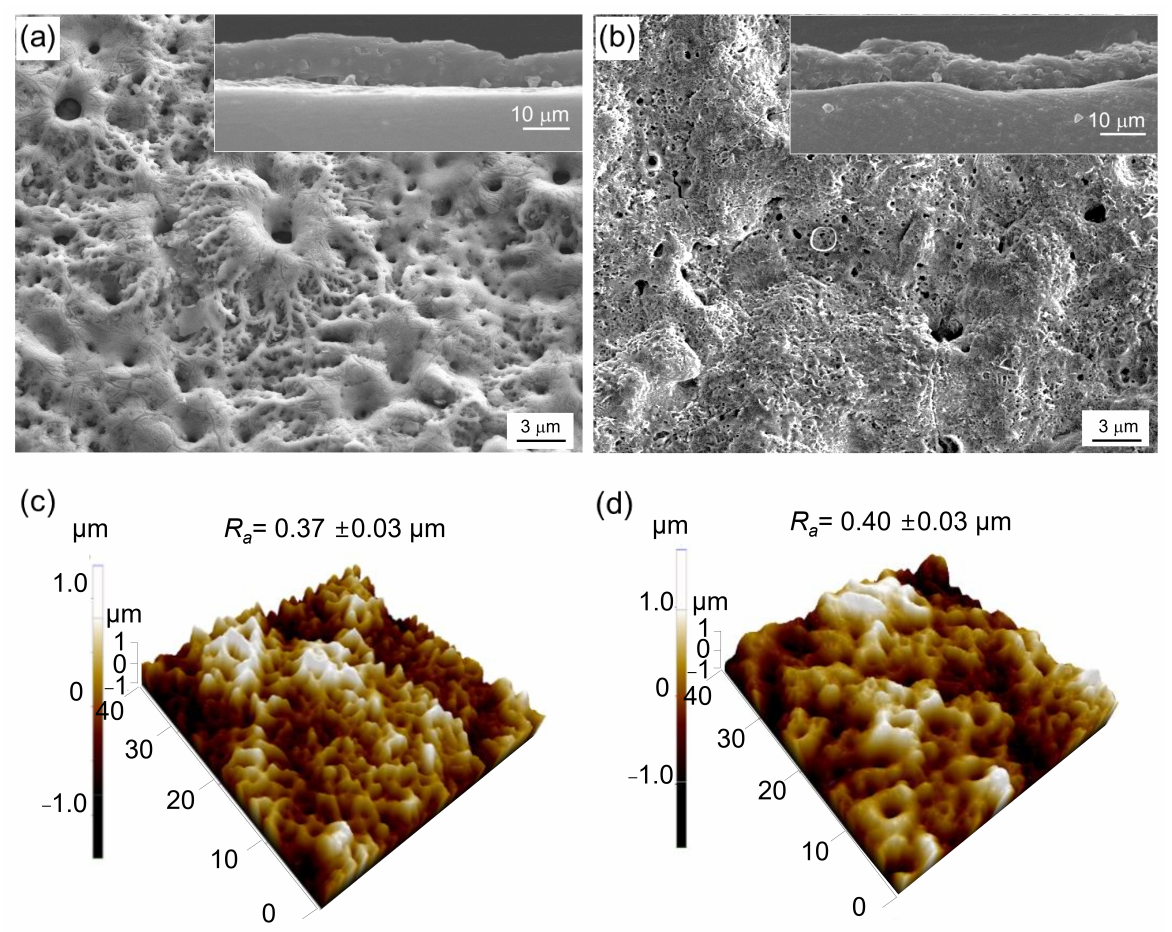
Figure 3. SEM images showing the surface morphologies of the oxide layer formed in ( a ) bath A and ( b ) bath B, respectively, with their cross-section as an inset. AFM images showing the surface morpholo- gies of the present samples treated in ( c ) bath A for 10 min and ( d ) bath B for 2 min, respectively.